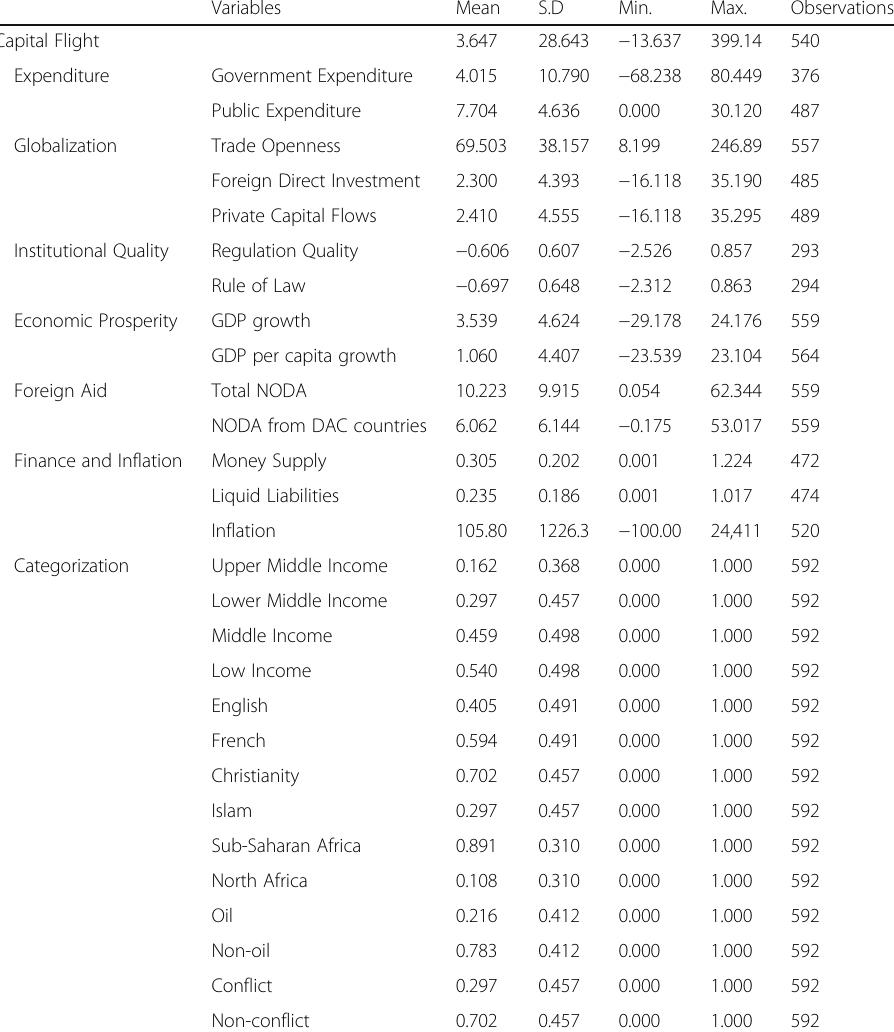
Table 5 Summary